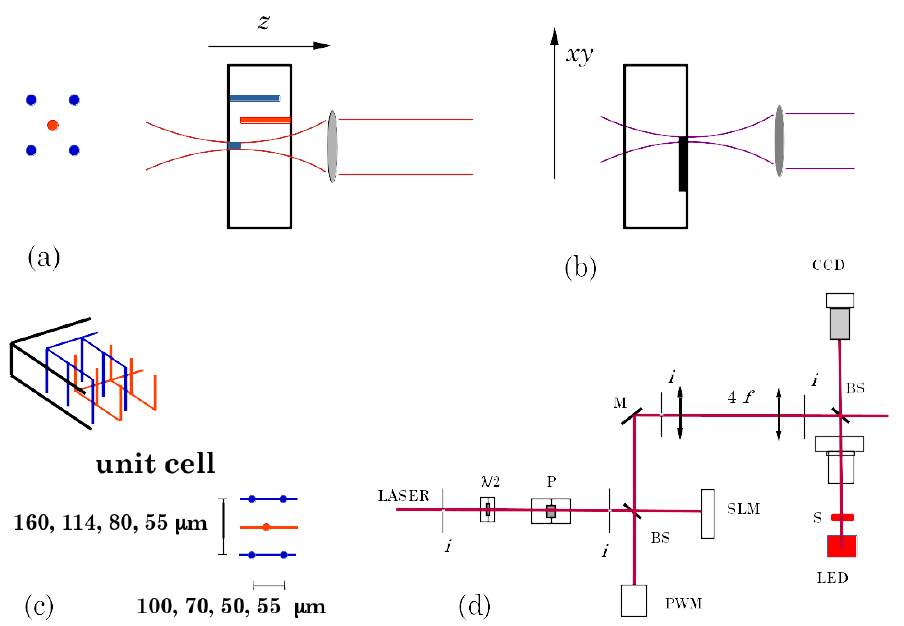
Figure 1. Fabrication process schematics. ( a ) We write the conductive columns in the bulk of the diamond by translating the fs laser beam waist along the optical axis (z), i.e., along the thickness of the sample. ( b ) We connect the electrodes for implementing test structures by writing graphitic paths on the diamond surface with ns laser irradiation. ( c ) The figure shows the interpenetrating matrices of bulk electrodes (bias columns and signal columns). It also shows the unit cell sizes implemented (see text.) ( d ) The figure shows an oversimplified description of the optical setup. We align the laser beam through the irises ( i ). The beam passes through a rotatable λ /2 lamina and a polarizer (P), from which we control the input power via the power meter (PWM), then it is collimated on the spatial light modulator (SLM.) Upon reflection, it is collected by a 4f-system, then focused with a high numerical aperture objective on the sample (S), mounted on a xyz stage. A computer controls all the steps of the process via python